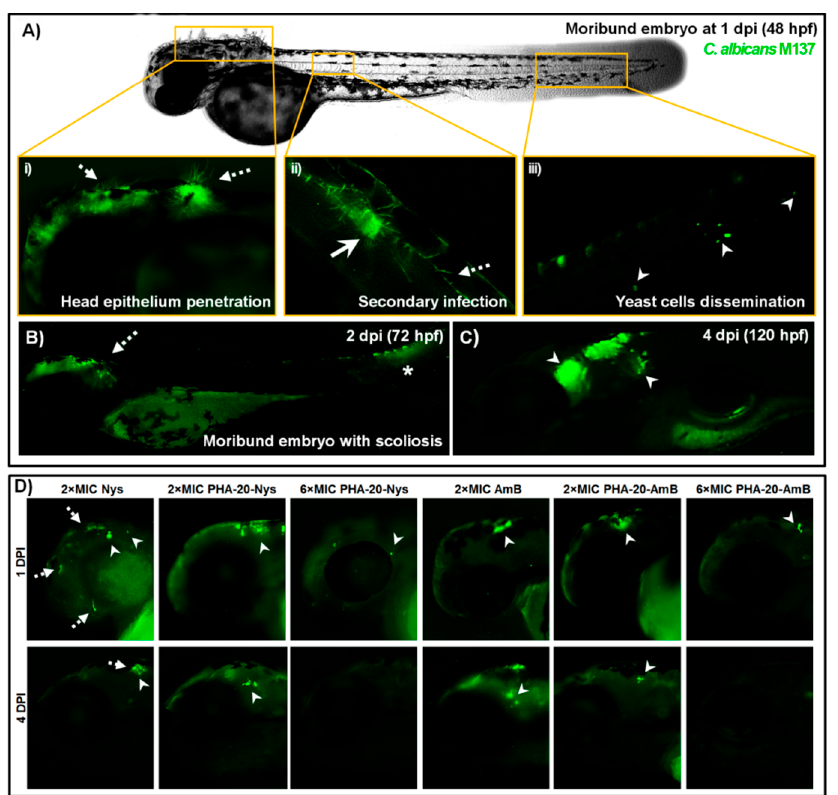
Figure 7. The treatments with the polyene-loaded microsphere led to the complete inhibition of C. albicans filamentation and prevented the infection dissemination. ( A ) The infection was developed in an untreated zebrafish embryo within 24 h following the injection of 40–70 of GFP-labeled cells of C. albicans (strain M137) into the hindbrain. During the first 24 h post infection (1 dpi), fungus filamented and penetrated the head epithelium (dashed arrow) (i), and disseminated into the caudal region forming the secondary foci of the infection (ii). The disseminated yeast-form cells (arrowhead) have also been detected at the end of the tail (iii). ( B ) Some of the untreated embryos that did not succumb the Candida infection by 1 dpi were malformed and moribund at 2 dpi (72 hpf), with the yeast-like structures present at the site of the body distortion (asterisk). Others that survived by 120 hpf had no visible malformations and the fungal infection mainly occurred within the head (arrowhead) ( C ). In contrast to this, fungal filamentation was successfully inhibited by 2 dpi upon the treatments with 2 × MIC doses of free polyenes, PHA-20-Nys and PHA-20-AmB, while Candida infection has not been detected at 4 dpi (120 hpf) in the fish treated with 6 × MIC dose of the polyene-loaded microspheres ( D ).